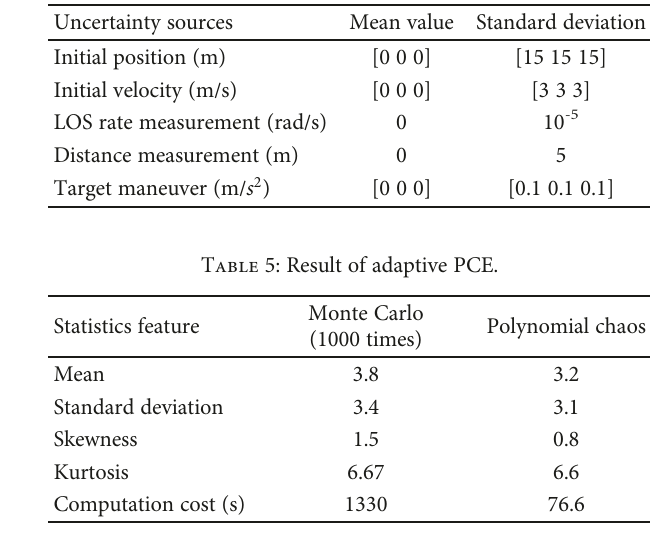
Table 4: Uncertainty sources.